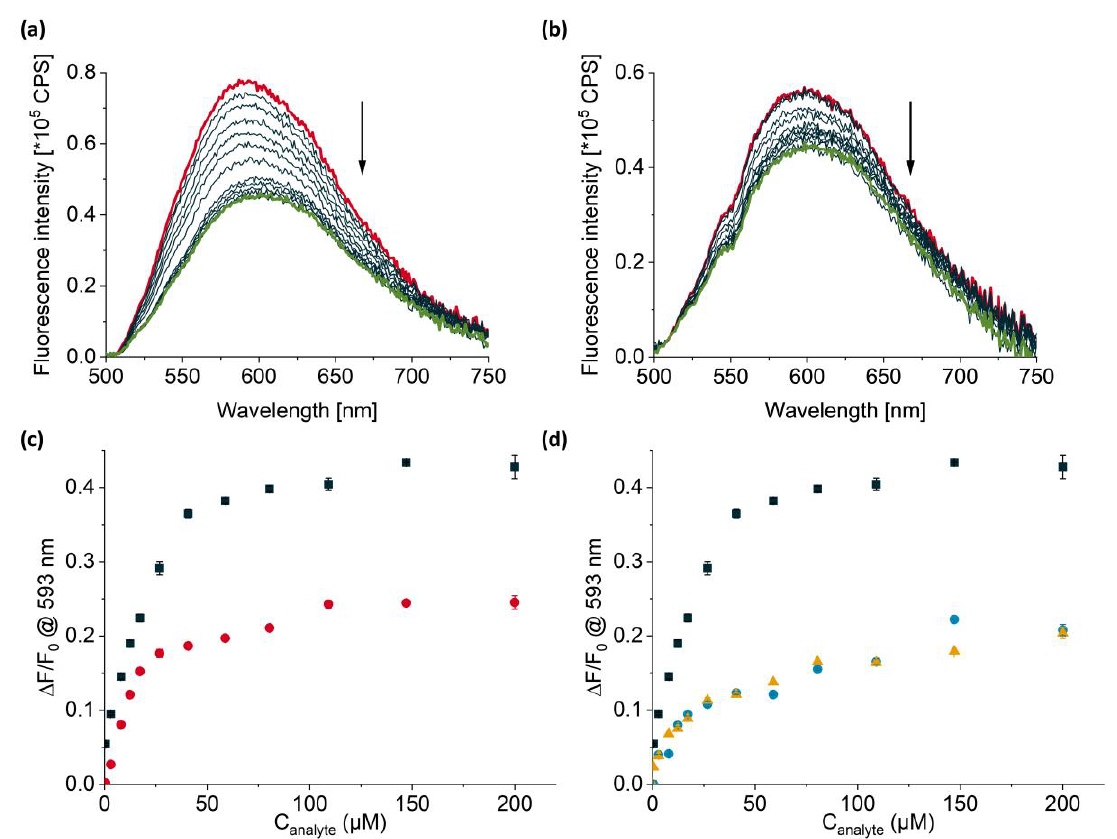
Figure 7. Fluorescence titration spectra of ( a ) MIPa@SiO 2 and ( b ) dNIPa@SiO 2 upon titration with ∆ F up to 200 µ M GPS-TBA in CHCl 3 . ( c ) Relative fluorescence changes, , at 593 nm of MIPa@SiO 2 F 0 (black squares) and dNIPa@SiO 2 (red circles) upon titration with up to 200 µ M GPS-TBA in CHCl 3 . ∆ F ( d ) Relative fluorescence changes, , at 593 nm of MIPa@SiO 2 upon titration with up to 200 µ M F 0 GPS-TBA (black squares), 2,4-D-TBA (blue circles) and dicamba-TBA (orange triangles) in CHCl 3 . λ ex = 474 nm. Here, 2 mL of 1 mg mL − 1 particle suspensions in CHCl 3 were used for the